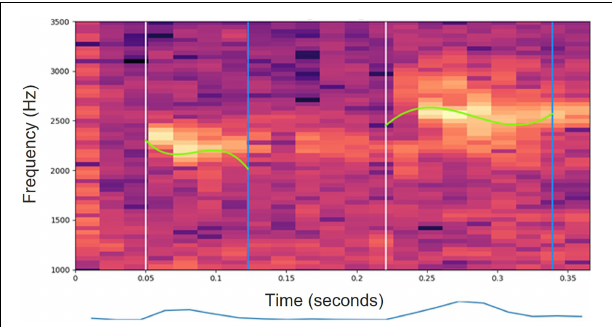
FIGURE 4 | A spectrogram of two syllables of a White-Spectacled Bulbul ( Pycnonotus xanthopygos ). The fundamental frequency contour modeled by a 3rd degree Legendre polynomial is superimposed on the spectrogram. The lower graph depicts the short-time energy of the syllables.